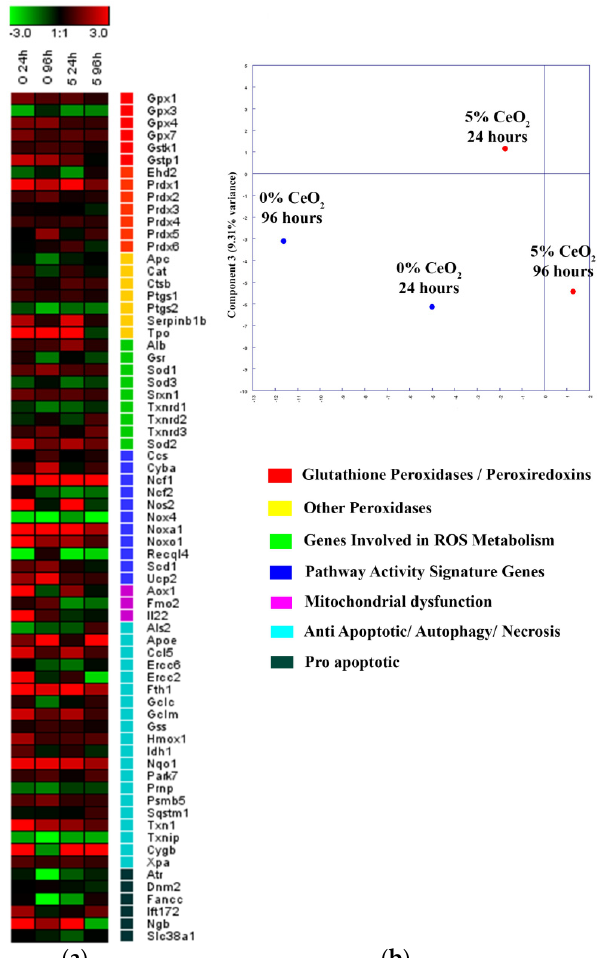
Figure 9. Heat map of gene expression in mouse MSC, cultured on 0% and 5% CeO 2 -containing scaffolds, after 24 and 96 h of cultivation. ( a ) The intensity scale of the standardized expression values ranges from − 3 (green: low expression) to +3 (red: high expression, with 1:1 intensity value (black) representing the control (nontreated). Principal component analysis (PCA) of qRT-PCR data for different concentrations of CeO 2 scaffold ( b ). Cluster groups of genes and their functionality.